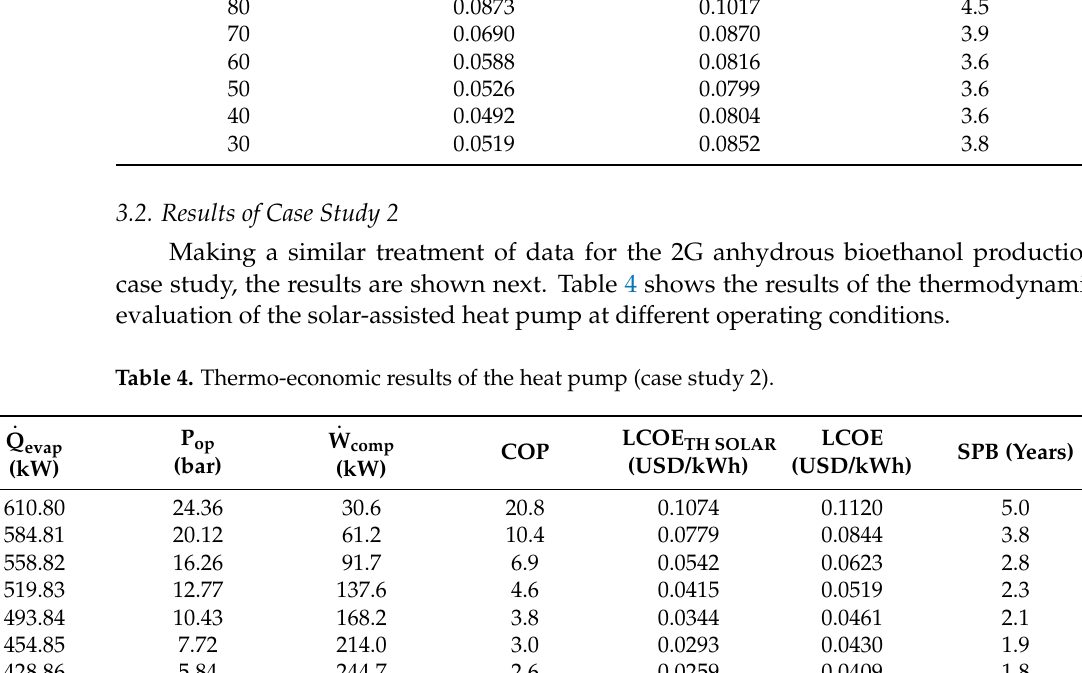
Table 4. Thermo-economic results of the heat pump (case study 2).